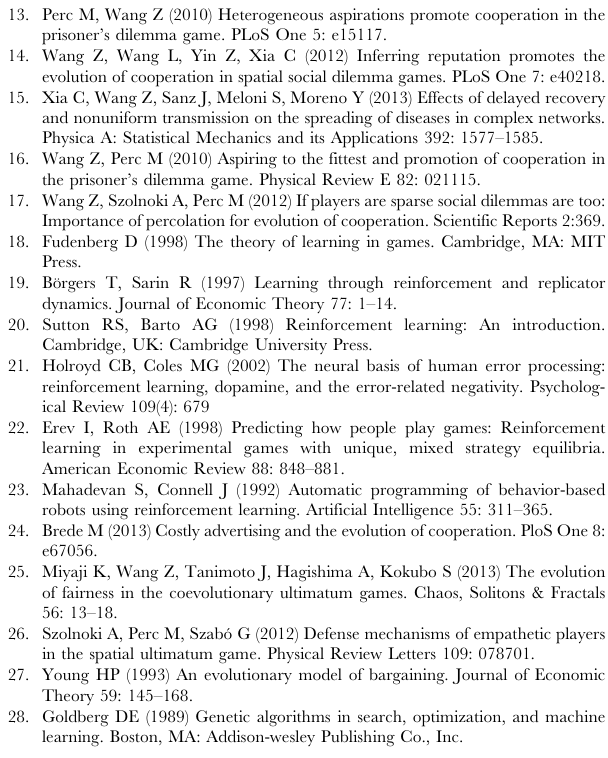
Table S1 Variables and formulas. Average payoff of buyer, average payoff of seller, joint payoff, average round and fairness are calculated with the corresponding